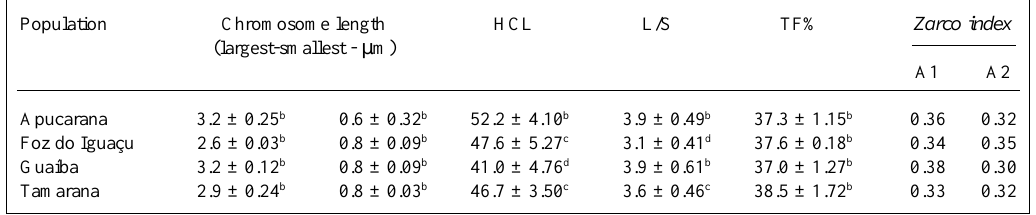
Table III - Chromosome length ( m m), haploid chromosome length (HCL), ratio of longest/shortest chromosomes (L/S), and karyotype symmetry using total form (TF%) and Zarco index of four tetraploid cytotypes of Mikania micrantha with 2n = 72 chromosomes. a